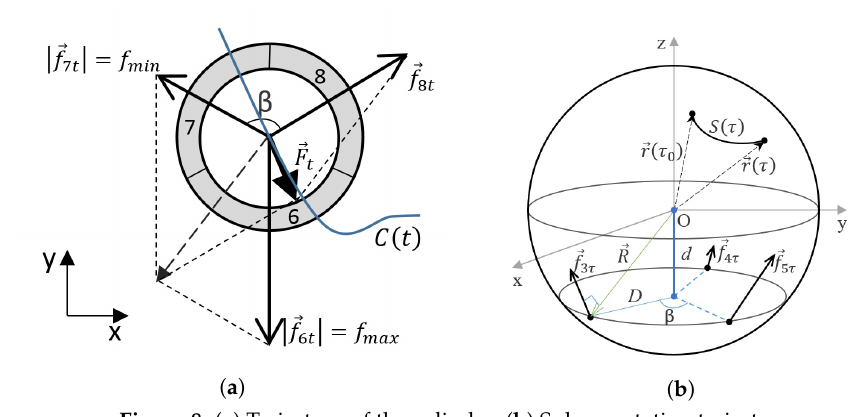
Figure 8. ( a ) Trajectory of the cylinder; ( b ) Sphere rotation